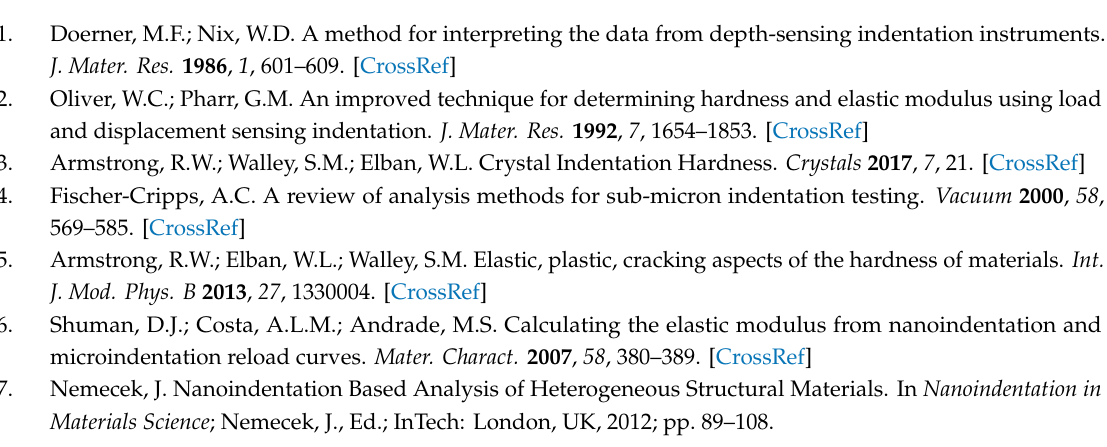
Figure S1: Residual analysis of the fit to the azimuthal indenter